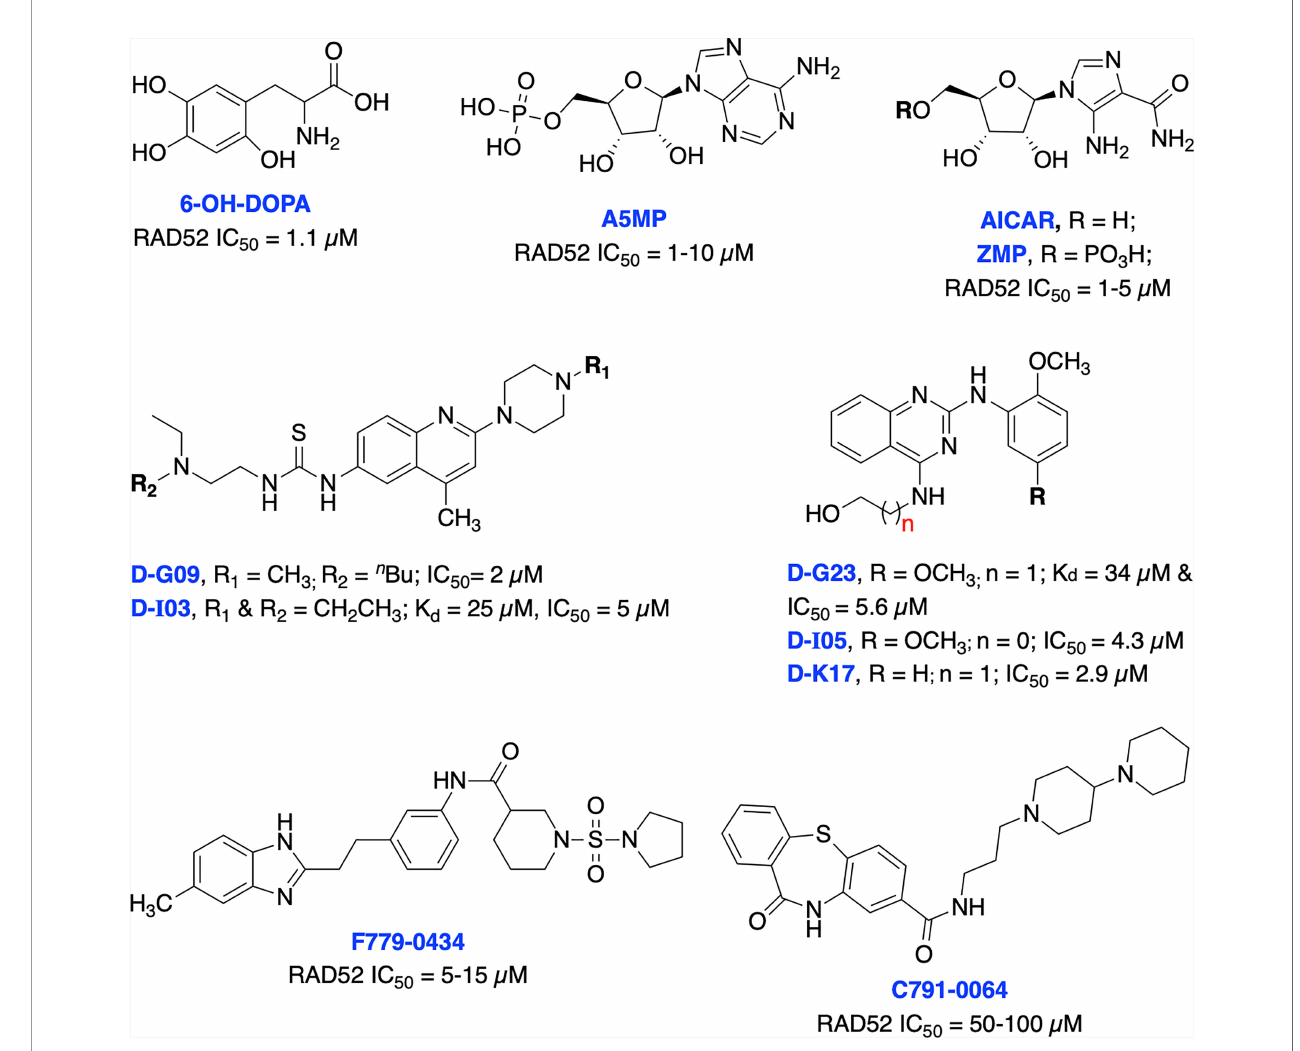
FIGURE 11 | Small molecule inhibitors targeting RAD52 with their respective Kd/IC50 values for either RAD52 binding or ssDNA annealing